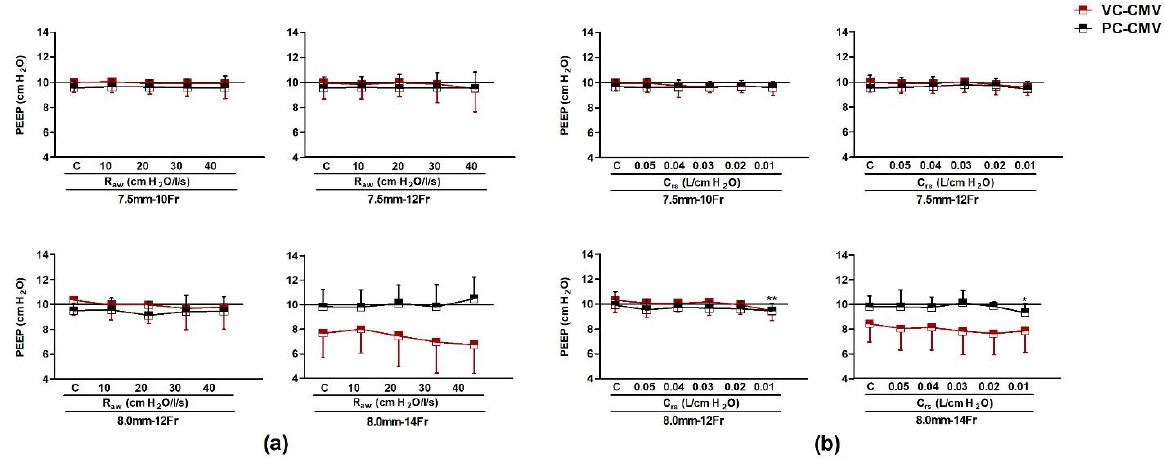
Figure 4. The effects of 7.5 mm and 8.0 mm ETT with 10 Fr, 12 Fr, and 14 Fr SC on PEEP in different respiratory systems: ( a ) Changes in airway resistance of pulmonary mechanics for the obstructive system; ( b ) Changes in lung compliance of pulmonary mechanics for the restrictive system in VC-CMV and PC-CMV. PC-CMV: pressure control continuous mandatory ventilation, this mode set inspiratory pressure at 20 cm H 2 O with inspiratory time at 1 sec; VC-CMV: volume control continuous mandatory ventilation, this mode is set to VT 0.6 L with peak flow 60 Lpm; C: control group (0.08 L cm H 2 O −1 of C rs and 5 cm H 2 O ･ L −1 ･ s of R aw ); PEEP: positive end-expiratory pressure placed 10 cm H 2 O (solid line); R aw : airway resistance; C rs : lung compliance; ETT: endotracheal tube; SC: suction catheter; 7.5 mm−10 Fr: 7.5 mm ETT paired with 10 Fr SC, and so on. The closed suctioning procedure was repeated three times. The error bars represent the standard deviation of 30 breaths in each of the pulmonary mechanic scenarios (five airway resistance levels and six lung compliance levels). The independent samples t -test was used to compare with the control group. * p < 0.05, ** p < 0.01.